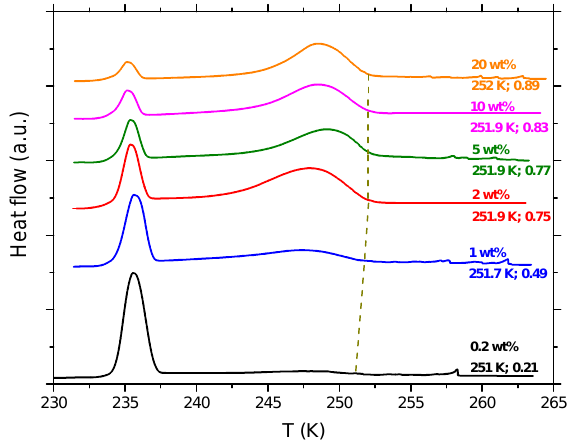
Figure 2. DSC thermograms of varying suspension concentrations of microcline particles in pure water. All curves are normalized such that the areas under the heterogeneous and homogeneous freezing curves sum up to the same value. Numbers next to each curve: dust concentration (in wt%), onset temperature T het (in K) and heteroge- neously frozen fraction F het (ratio of heterogeneous to total freez- ing signals, dimensionless), respectively. Note that the spikes at T > 255K are due to the freezing of single, particularly large emul- sion droplets. They are not reproducible and therefore excluded from